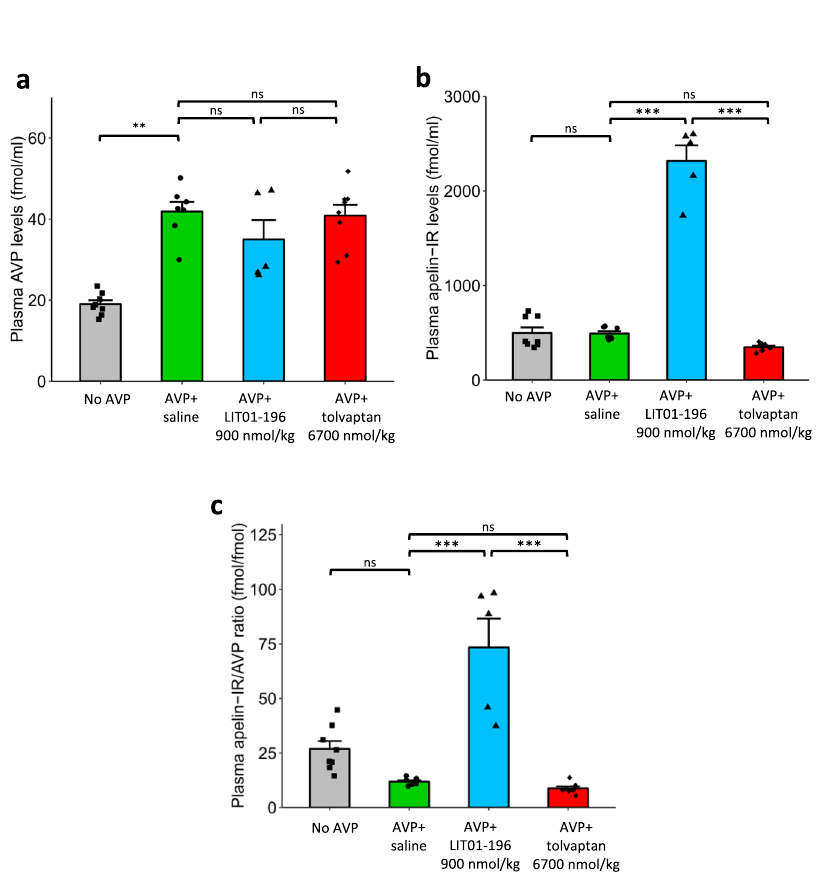
Fig. 6 Plasma AVP and apelin levels in hyponatremic rats receiving saline, LIT01-196, and tolvaptan, relative to normonatremic rats. Measurements of plasma AVP levels ( a ), plasma apelin-IR levels ( b ), and plasma apelin-IR/AVP ratios ( c ) in alert male Srague – Dawley rats receiving a semi-liquid diet and no AVP (gray bars, squares, n = 8 animals), a 48-h s.c. infusion of AVP at a rate of 30 ng/h together with a s.c. injection of saline (green bars, circles, 1 ml/ kg, n = 7 animals), LIT01-196 (blue bars, triangles, 900nmol/kg, n = 5 animals) or tolvaptan (red bars, diamonds, 6700 nmol/kg, n = 8 animals) 3 h before blood collection. Data are shown as mean ± SEM. Multiple comparisons performed by ANOVA with Tukey ’ s adjustment for multiple comparisons. n.s.: P > 0.05, ** P < 0.01, and *** P <